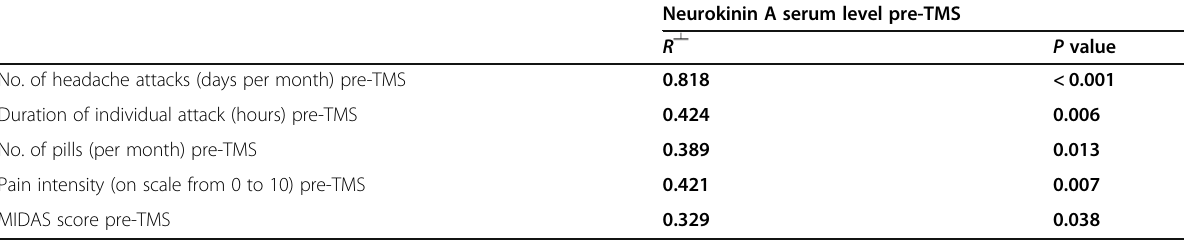
Table 5 Correlation between neurokinin A serum level and clinical parameters of migraine pre-TMS